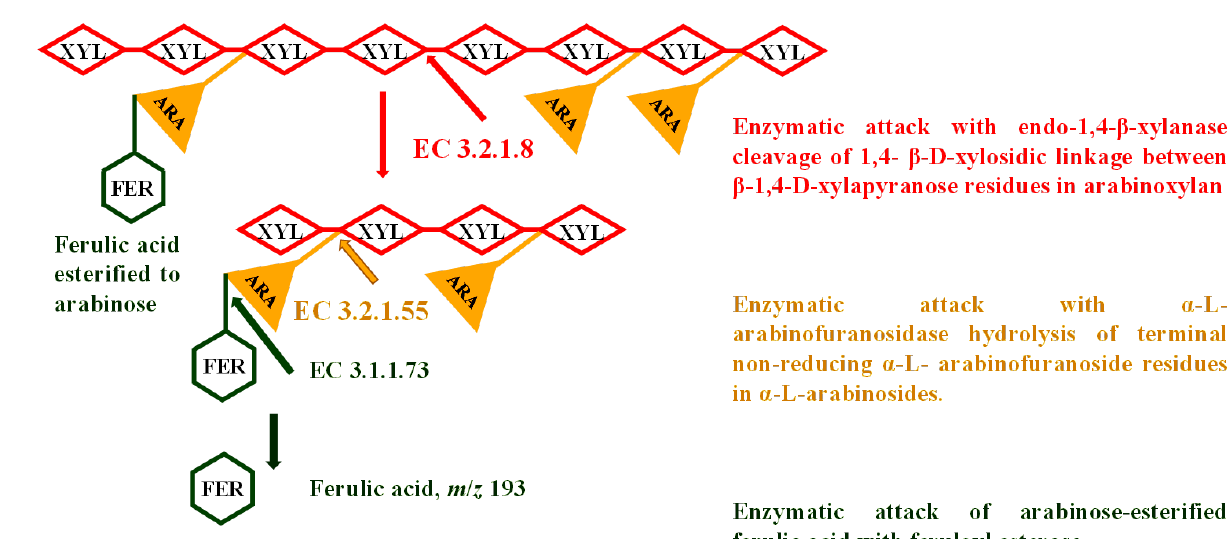
Figure 1. Simplified sketch of the enzymes’ synergistic effect in the hydrolysis of arabinoxylan found in cereal bran and involvement of them in the release of esterified ferulic acid (FER). The action of endo-1,4-β-xylanase results in the cleavage of internal 1,4-β- D -xylosidic linkages in β-1,4- D -xylapyranose residues of xylans (XYL). Hydrolysis of non-reducing end of terminal α - L - arabinofuranoside residues in α - L -arabinosides by α - L -arabinofuranosidase results in the release of feruloylated arabinose (ARA) monomers. The final attack of ester linkages between arabinose and ferulic acid with feruloyl esterase results in the release of free ferulic acid.